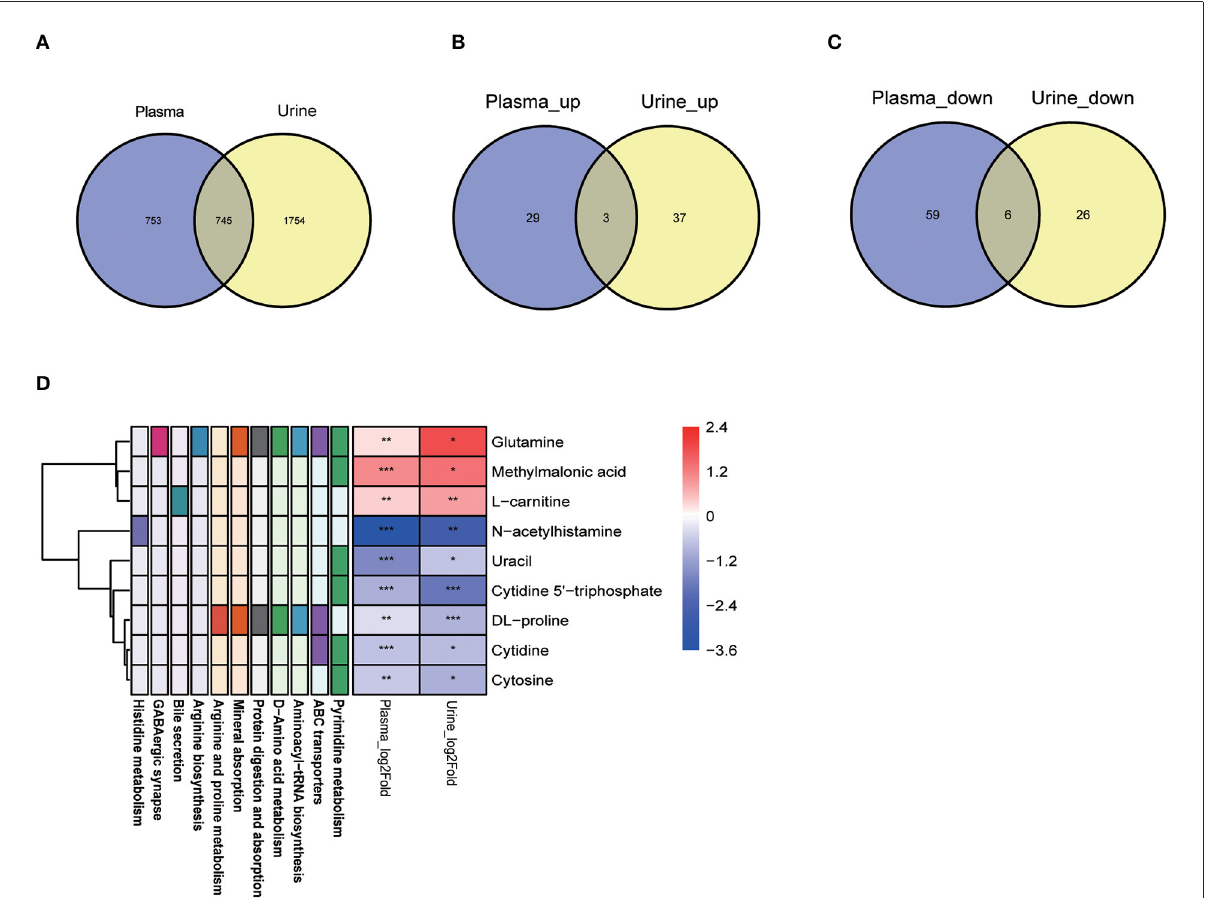
FIGURE7 Amino acids and their derivatives were conserved metabolites reflecting development in both plasma and urine. (A) Venn diagram showed 1,498 and 2,499 metabolites identified from plasma and urine, respectively; (B, C) Only three significantly increased metabolites and six significantly decreased metabolites were observed in both the plasma and the urine of adult dogs. Purple represents the plasma samples and yellow represents the urine samples. (D) The nine metabolites derived from (B, C) involved in multiple metabolic pathways. For the metabolite lists: red represents increased (VIP > 0) and purple represented decreased abundance (VIP < 0) in adult dogs. For the metabolic pathways: different colors of the box represent the different metabolic pathways involved by the corresponding metabolites. * P < 0.05, ** P < 0.01, *** P < 0.001 vs. young